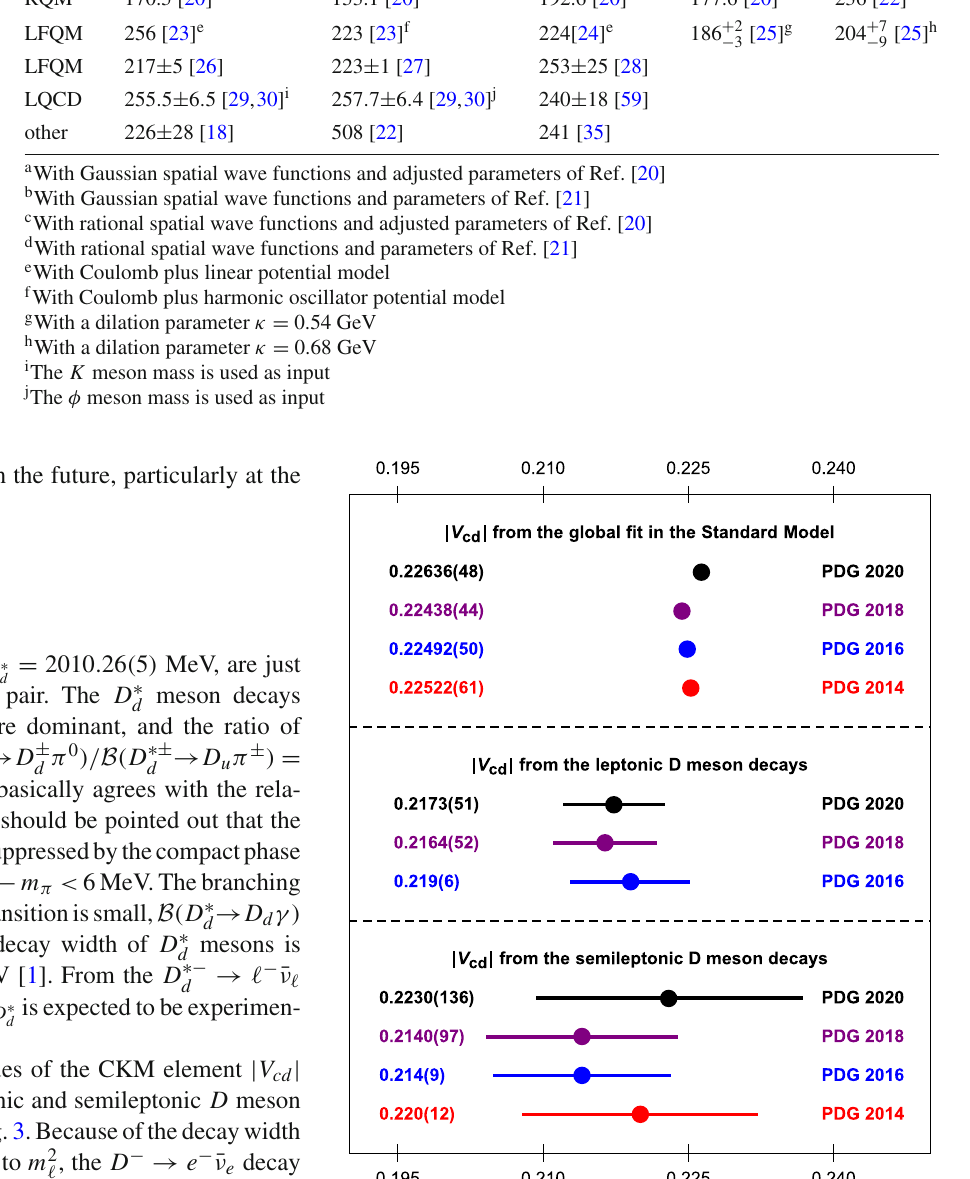
Table 2 The theoretical values of decay constant f K ∗ (in the unit of MeV), where the legends are the same as those in Table 1